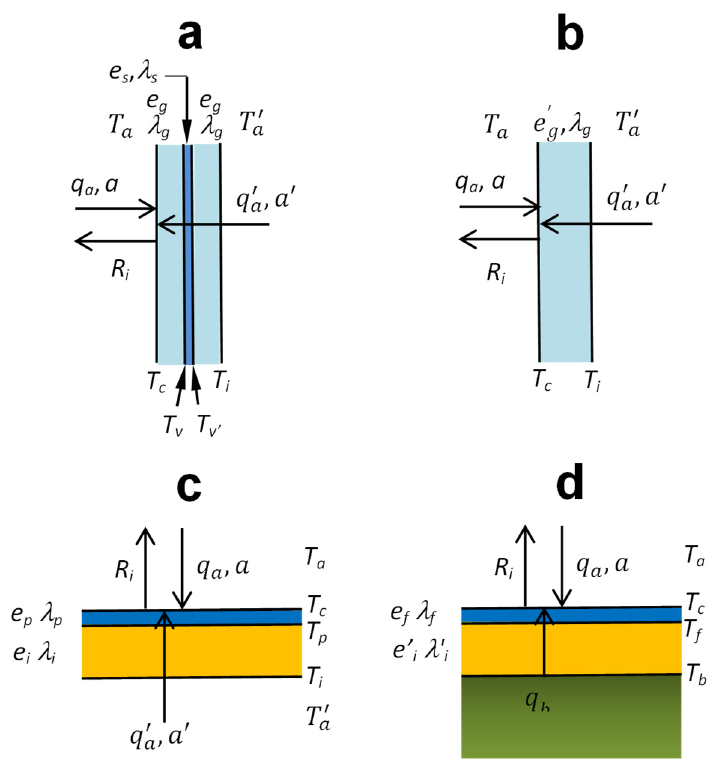
Figure 4. Characteristics of ( a ) windshield, ( b ) other windows ( c ) roof top, and ( d ) reference condenser. Thicknesses are denoted by e , thermal conductivity by λ , heat transfer coefficients by a , temperatures by T . Subscripts correspond to: a —air, g —glass, s —sandwich film, p , rooftop metal, i , thermal isolation, b —ground basis. Superscripts ‘ and ‘’ correspond to different values. R i is the radiative deficit flux.